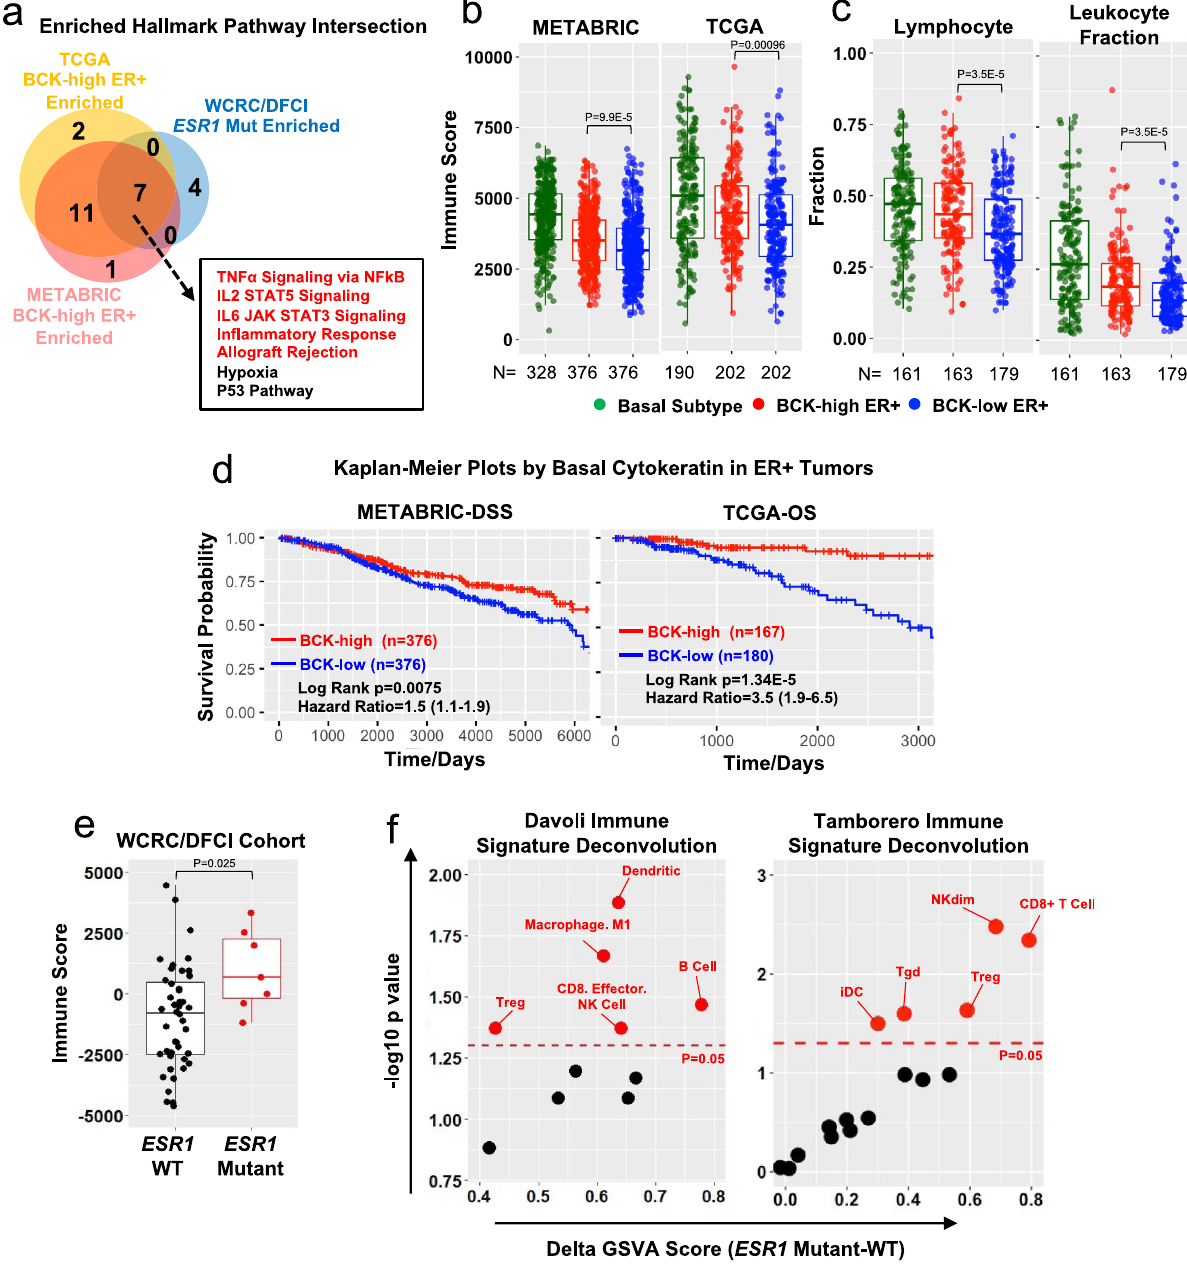
Fig. 5 Gain of basal cytokeratin expression is associated with enhanced immune activation in ESR1 mutant tumors. a Venn diagrams showing the intersection of signi fi cantly enriched hallmark pathways in three sets of comparisons: BCK-high vs low in 1) TCGA ER + tumors ( n = 202 in each group), 2) METABRIC ER + tumors ( n = 376 in each group) and 3) ESR1 mutant ( n = 7) vs. WT ( n = 44) metastatic tumors. BCKs high and low were de fi ned by the upper and bottom quartiles of each subset. The seven overlapping pathways are shown in a frame, and immune-related pathways are highlighted in red. b Immune scores based on ESTIMATE evaluations in basal tumors (METABRIC n = 328; TCGA n = 190), BCK-high (METABRIC n = 376; TCGA n = 202) and low (METABRIC n = 376; TCGA n = 202) subsets of ER + tumors. Box plots span the upper quartile (upper limit), median (center) and lower quartile (lower limit). Whiskers extend a maximum of 1.5× IQR. Mann – Whitney U -test (two-sided) was used for comparison. c Lymphocytes and leukocyte fractions 67 comparisons among TCGA basal subtype tumors ( n = 161), ER + BCK-high ( n = 163) and low ( n = 179) tumors. Box plots span the upper quartile (upper limit), median (center) and lower quartile (lower limit). Whiskers extend a maximum of 1.5× IQR. Mann – Whitney U -test (two-sided) was applied. d Kaplan – Meier plots showing the disease-speci fi c survival (DSS) (METABRIC) and overall survival (OS) (TCGA) comparing patients with ER + BCKs high vs. low tumors. Censored patients were labeled in cross symbols. Log-rank test (two-sided) was used and hazard ratio with 95% CI were labeled. e Immune scores based on ESTIMATE evaluations in ESR1 mutant ( n = 7) and WT metastatic ( n = 44) lesions. Box plots span the upper quartile (upper limit), median (center) and lower quartile (lower limit). Whiskers extend a maximum of 1.5× IQR. Mann – Whitney U -test (two-sided) was used. f Dot plot showing the enrichment level alterations of immune cell subtypes in ESR1 mutant metastatic lesions using Davoli 68 and Tamborero 69 signatures between ESR1 mutant ( n = 7) and WT ( n = 44) tumors. Signi fi cantly increased immune cell subtypes in ESR1 mutant tumors were labeled in red ( p < 0.05). Source data are provided as a Source Data fi le for b – f